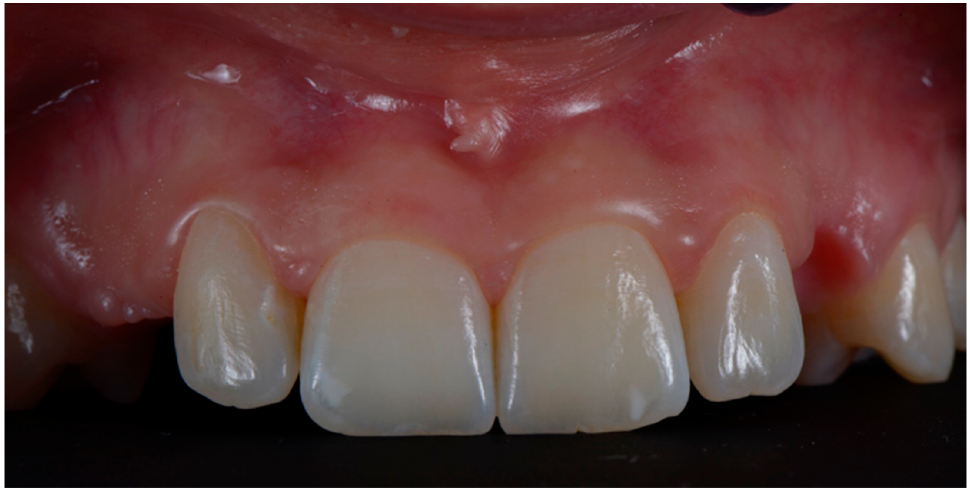
Figure 1. Case of edentulous upper canines following surgical extraction of the impacted elements. Preliminary photo before surgical treatment.